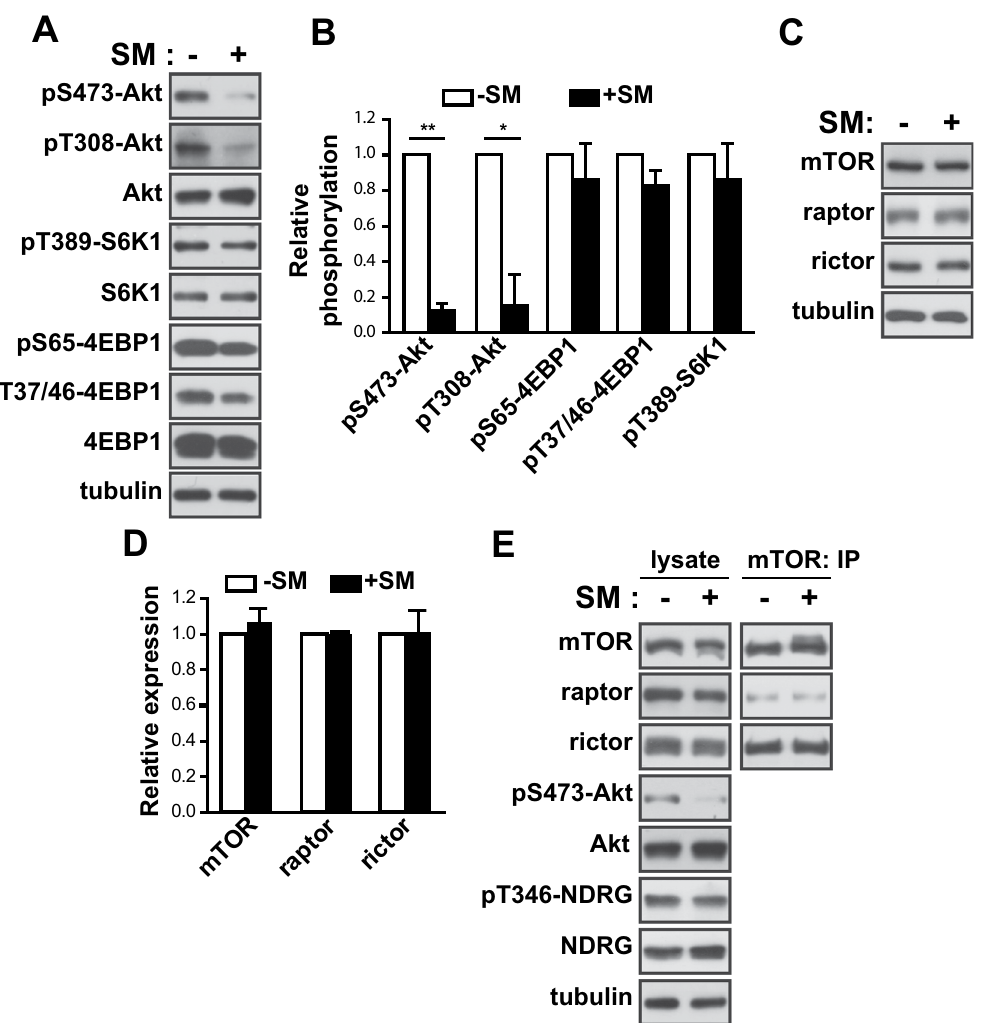
Figure 3. SM decreased Akt activity in human eSCs. ( A – D ) Human eSCs were incubated either under terrestrial gravity (1 g ) or under SM for 36 h, lysed, and analyzed by western blotting ( A,C ). Western blot images were analyzed using ImageJ to determine the phosphorylation of pS473-Akt relative to Akt, pT308-Akt relative to Akt, pT389-S6K1 relative to S6K1, pS65-4EBP1 relative to 4EBP1, and pT47/36-4EBP1 relative to 4EBP1 ( B ), and the expression of mTOR, raptor, and rictor relative to tubulin ( D ). The cells were treated as in (A), subjected to immunoprecipitation using antibodies against mTOR, and analyzed by western blotting. Abbreviations: simulated microgravity (SM). Data are expressed as mean ± SD, with paired t -tests performed as indicated. * P < 0.05, ** P < 0.01 versus control at each indicated